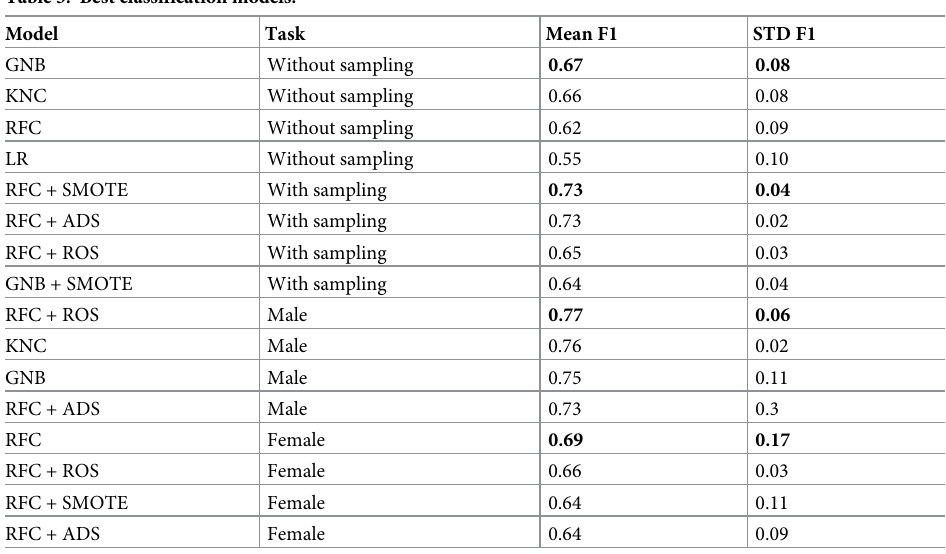
Table 3. Best classification